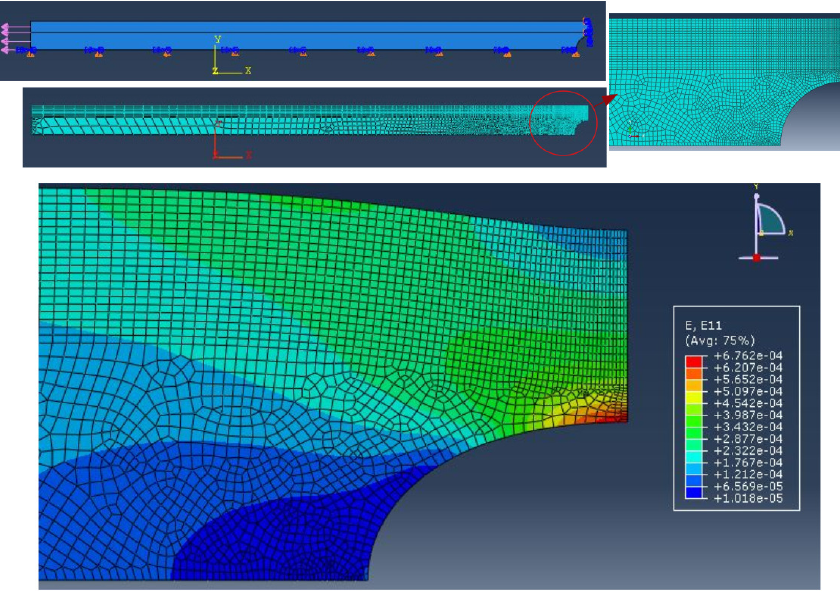
Figure 14. Finite element analysis of the sample (from ABAQUS by Dassault Systems ®